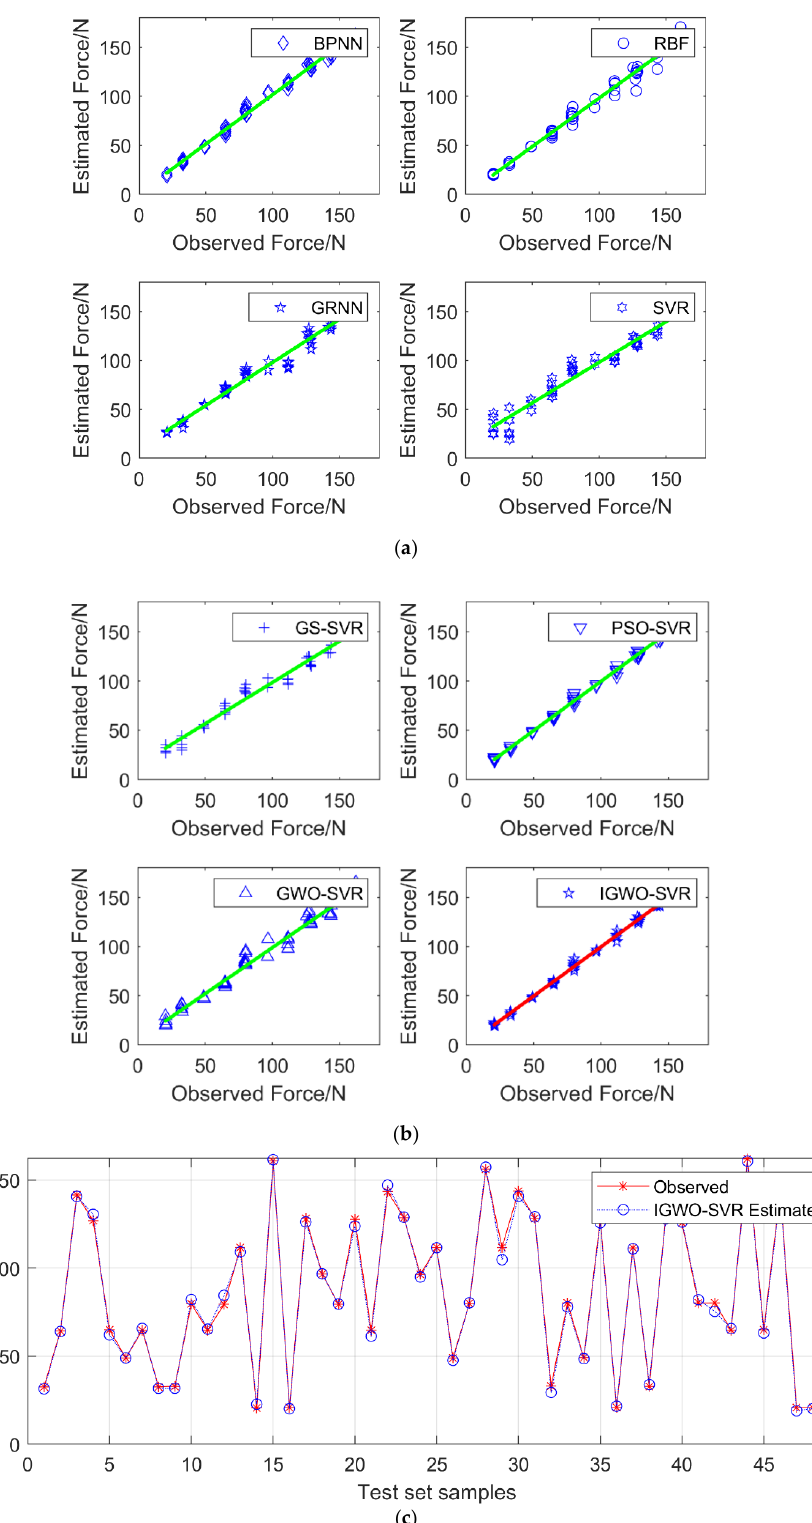
Figure 5. The estimation effects of knee joint extension force on S1 with different regression models at the joint angle of 90. ( a ) The fitting effects by BPNN, RBF, GRNN, and SVR. ( b ) The fitting effects by GS-SVR, PSO-SVR GWO-SVR, and IGWO-SVR. ( c ) The estimated results of the IGWO-SVR model for the test